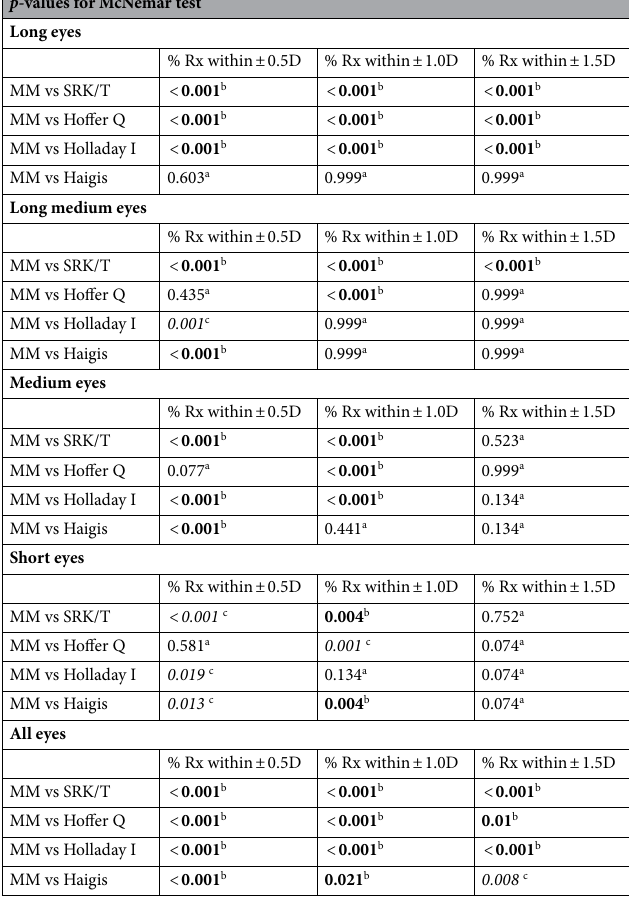
Table 4. Pairwise comparison of the prediction accuracy (i.e., the percentage of eyes within a given range of prediction error) between the MM formula and each of the other four formulae (SRK/T, Hoffer Q, Holladay I and Haigis) for the different types of eyes (long, long medium, medium, short and all eyes), using the McNemar test at a statistical significance level of 5%. a No statistically significant difference at level 0.05. b MM formula outperformed at significance level 0.05. c MM formula underperformed at significance level 0.05. Significant values are in [bold,